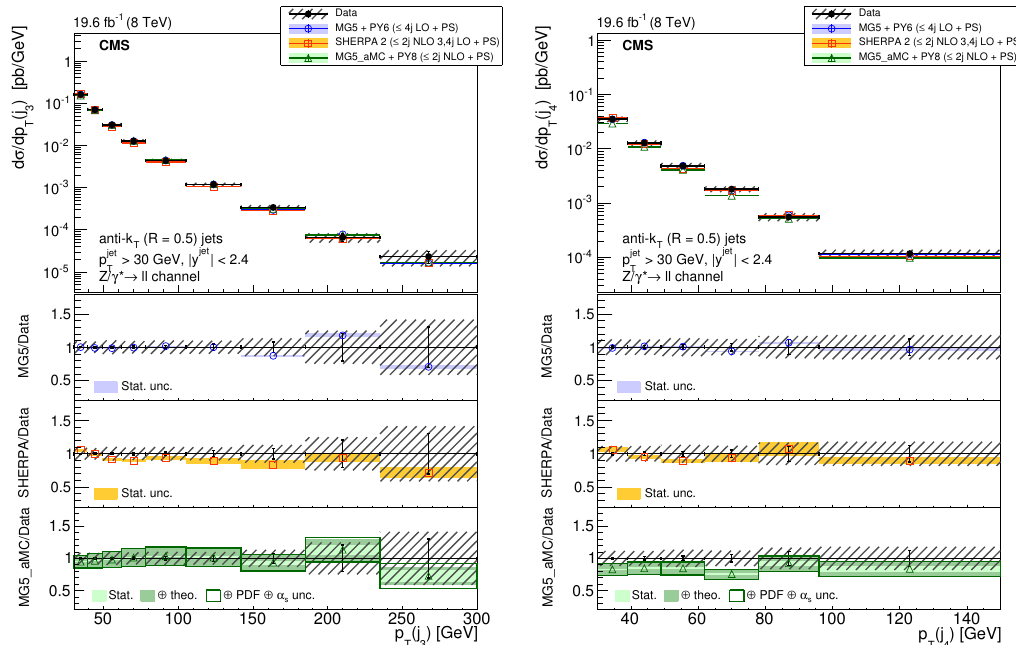
Figure 4 . The di(cid:11)erential cross section for Z ( ! ‘‘ ) + jets production measured as a function of the (left) 3 rd and (right) 4 th jet p T compared to the predictions calculated with MadGraph 5 + pythia 6, sherpa 2, and mg5 a mc + pythia 8. The lower panels show the ratios of the theoretical predictions to the measurements. Error bars around the experimental points show the statistical uncertainty, while the cross-hatched bands indicate the statistical and systematic uncertainties added in quadrature. The boxes around the mg5 a mc + pythia 8 to measurement ratio represent the uncertainty on the prediction, including statistical, theoretical (from scale variations), and PDF uncertainties. The dark green area represents the statistical and theoretical uncertainties only, while the light green area represents the statistical uncertainty